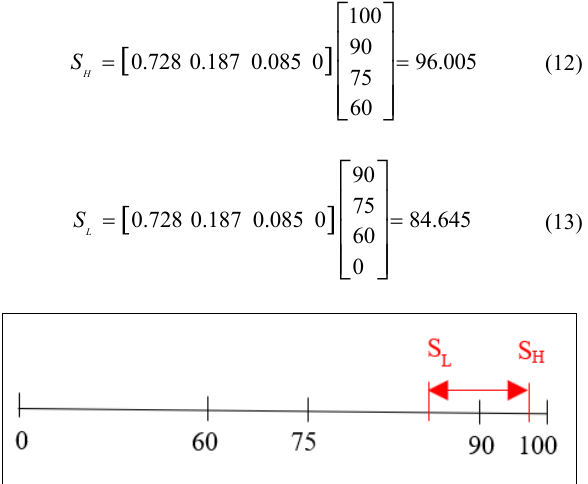
Figure 2. Quality level distribution probability